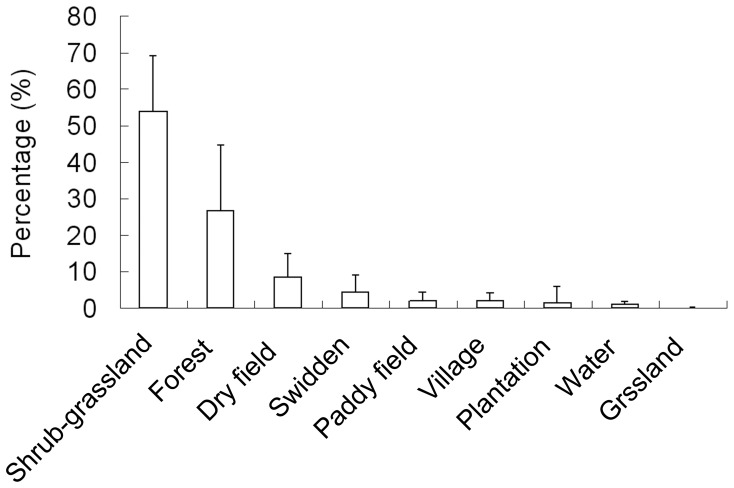
Average percentage of each patch category within the home range of an Eld’s deer.